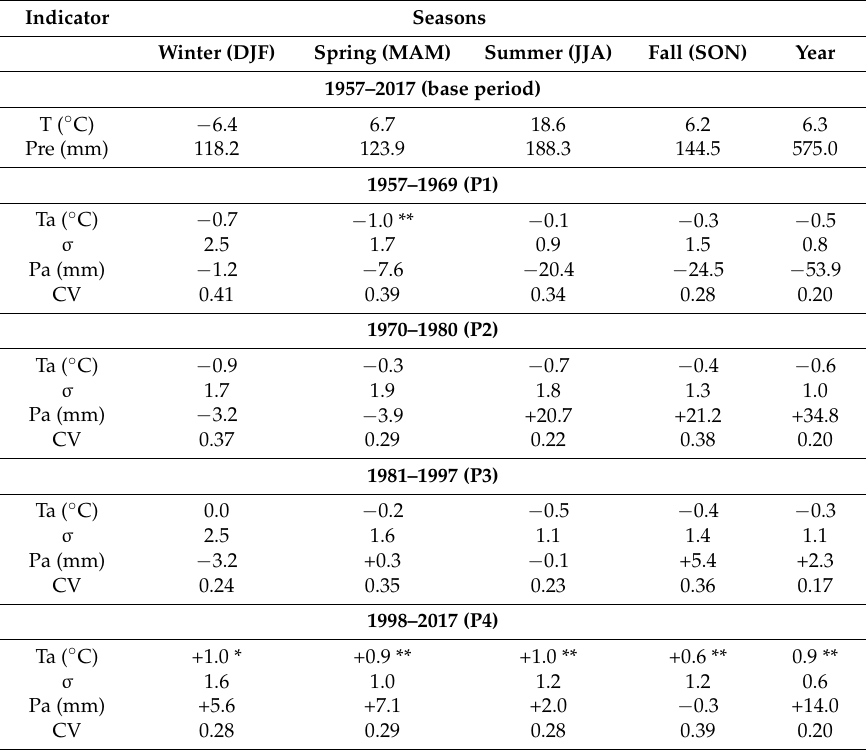
Table 2. Temperature ( ◦ C) and precipitation (mm) for the base period and anomalies (Ta) ( ◦ C), Pa (mm), and CV (2) over each season for the periods defined in Table 2 during the current epoch [4] as defined for the study region using the BELF surface data. Statistically significant values with respect to the base period are marked with a * at the 90% level, and ** at the 95% level. Indicator Seasons Winter (DJF) Spring